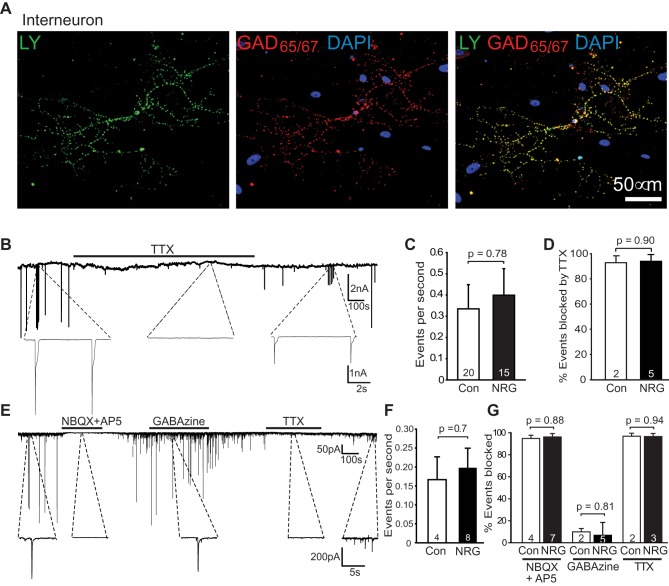
NRG does not affect neuronal activity.(A) Lucifer yellow filled patch-clamped interneuron, identified after recording by labelling for glutamate decarboxylase (GAD) 65/67, from which action potential evoked synaptic currents were recorded. DAPI labelling shows cell nuclei. (B) Spontaneous synaptic currents at −64 mV recorded in an interneuron with ECl = 0 mV. (C–D) Event frequency (C) and block by 1 µM TTX (D) in control and NRG cultures. (E) Spontaneous synaptic currents at −70 mV recorded with ECl = −88 mV, during application of 25 µM NBQX+50 µM D-AP5, or 10 µM GABAzine, or 1 µM TTX. (F–G) Event frequency (F) and block by NBQX/AP5, GABAzine, and TTX (G) in control and NRG cultures.